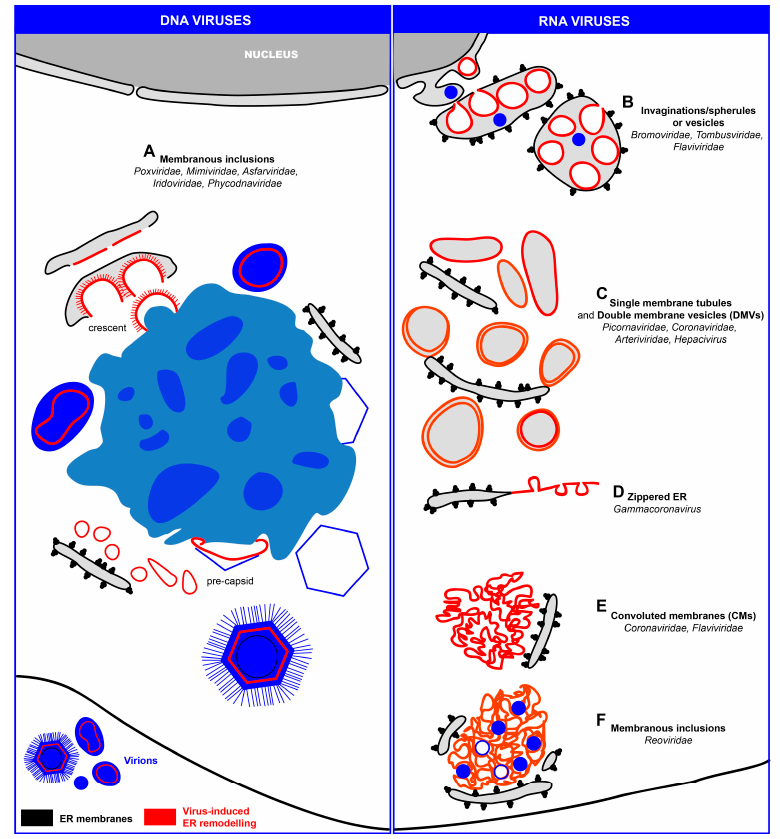
Figure 2. Schematic representation of ER modifications induced by DNA and RNA viruses (left and right panel, respectively). ( A ) Some DNA viruses (e.g., Poxviridae , Mimiviridae , Asfarviridae, Iridoviridae and Phycodnaviridae ) replicate their genomes in the cytoplasm in close association with ER ‐ derived membranes that are part of the replication and assembly factory. The single internal membrane bilayer of these viruses is generated through an unusual mechanism, comprising the generation of membrane sheets by rupture of ER cisternae in close proximity to the viral factories. There the single bilayers interact with capsid proteins to generate crescents and eventually pre ‐ capsids. These factories have an ordered organization, with a preference to accumulate the viral genomes in the factory center to facilitate continuous generation of virus progeny. The only exception known so far is PBCV ‐ 1 (not shown) that accumulates the viral genome at the periphery, while the single ‐ membrane bilayers localize to the center of the viral factory; ( B ) Some RNA viruses replicate their genomes in spherules (families Bromoviridae and Tombusviridae ) or vesicles (family Flaviviridae ), that are formed as invaginations towards the ER lumen; ( C ) Replication factories originating from “exvaginations” from the ER, giving rise to large single ‐ membrane tubules or double ‐ membrane vesicles (DMVs) (e.g., several members of the families Picornaviridae , Coronaviridae, Arteriviriridae, Hepacivirus ); ( D ) Infectious bronchitis virus (IBV, genus Gammacoronavirus ) induces mainly zippered ER membranes comprising tethered spherules. IBV also induces DMVs, albeit to low numbers; ( E ) ER ‐ derived convoluted membranes (CMs) are also found in cells infected with members of the Coronaviridae and Flaviviridae . Since these structures are devoid of ribosomes, they are most likely modified smooth ER membranes; ( F ) In reovirus ‐ infected cells, filled and empty virions ( Reoviridae ) are found embedded in a membranous inclusion of cellular origin (also called “viroplasm”) and closely surrounded by rough ER cisternae. Both ER elements and virus particles are in contact with the cytosolic face of the plasma membrane. Note that for reasons of simplicity, non ‐ ER intracellular organelles are not shown in this schematic.